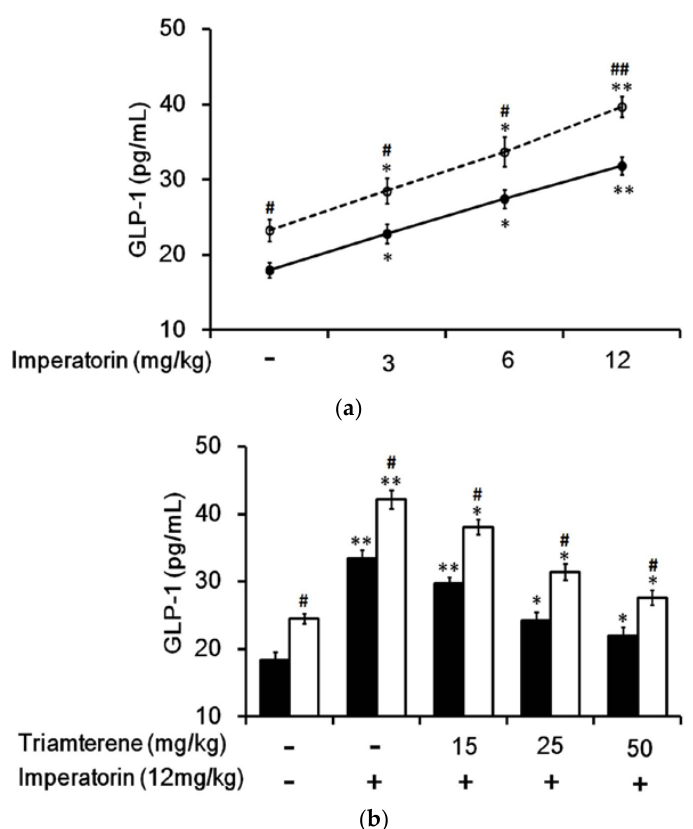
Figure 5. Effects of imperatorin on plasma GLP-1 levels in type 1-like diabetic rats. ( a ) Plasma GLP-1 levels were determined 45 min after the administration of imperatorin at the indicated dose in the vehicle-treated group (solid line) or the sitagliptin-treated (5 mg/kg/day orally for 14 days) group (broken line). ( b ) Triamterene inhibited the imperatorin-induced increases in plasma GLP-1 levels in diabetic rats that received vehicle (black column) or 5 mg/kg/day sitagliptin (open column) orally for 14 days. The diabetic rats were pretreated with triamterene at the indicated dose for 30 min. The values are expressed as the mean ± SEM obtained from eight samples per group. "-" is presented as 0 mol/L; "+" is presented as imperatorin treatment. * p < 0.05 and ** p < 0.01 compared with the vehicle-treated group. # p < 0.05 and ## p < 0.01 compared with the basal group without sitagliptin treatment.